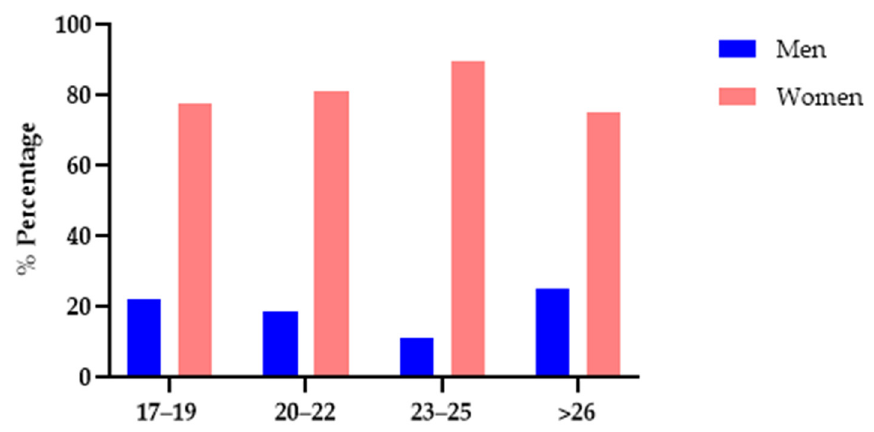
Figure 1. Distribution of age ranges according to sex.